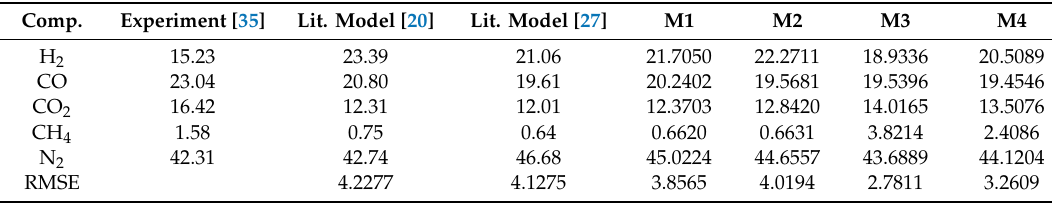
Table 2. Validation of models.